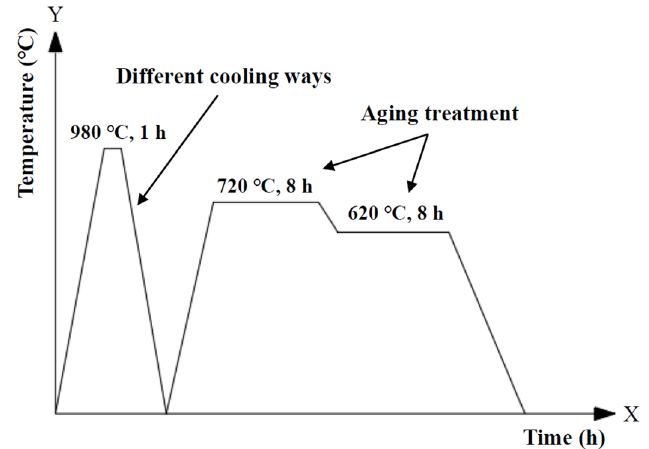
Figure 4. GH4169 alloy heat treatment process.